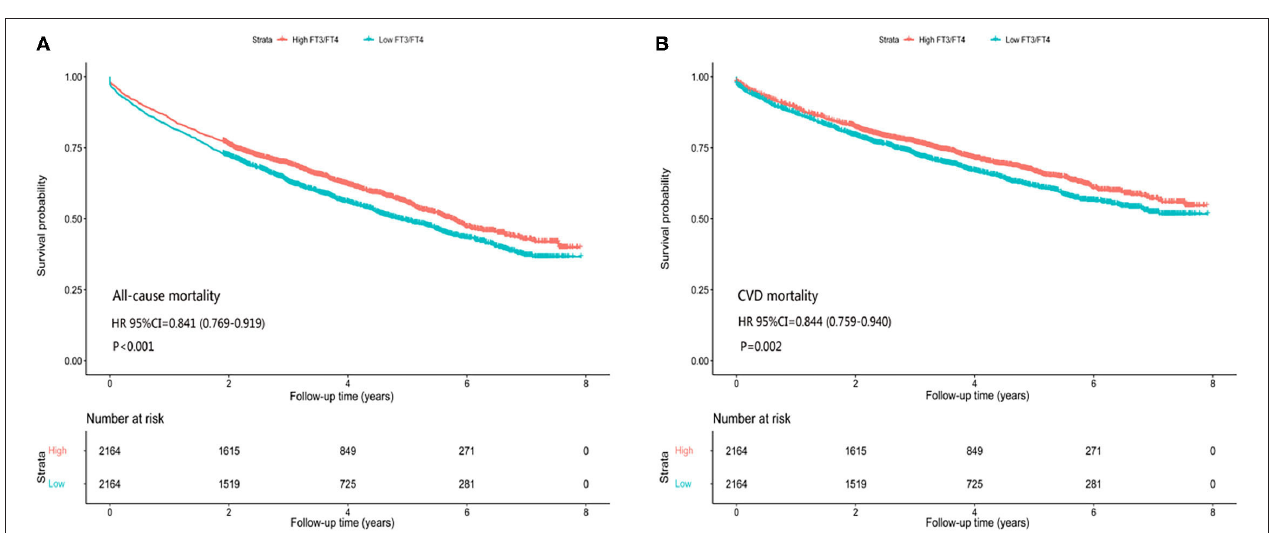
FIGURE 2 | Association of high and low FT3/FT4 ratio with all-cause/CV mortality in subgroups of propensity score-matched patients, (A) all-cause mortality, (B) CV mortality.